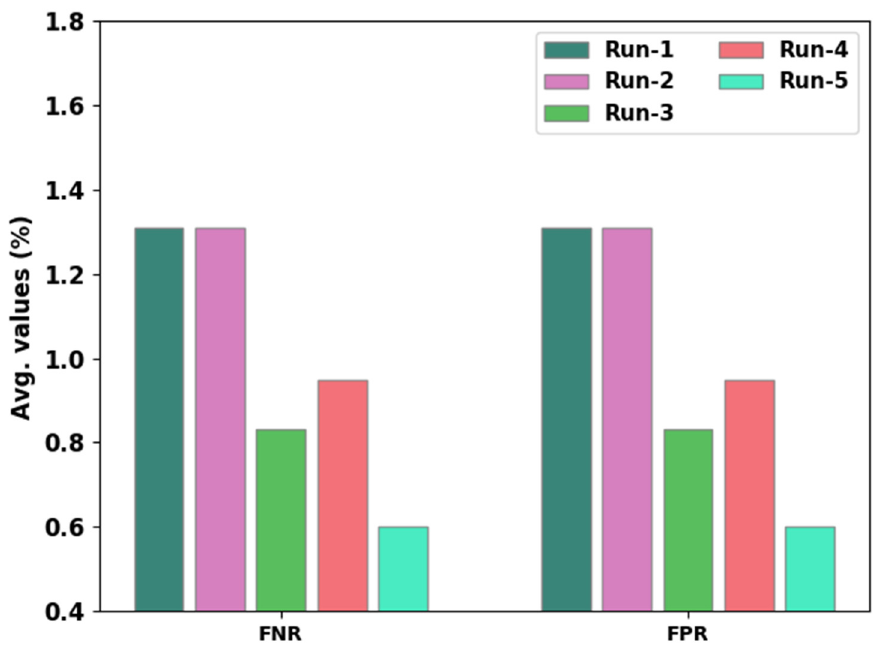
Figure 5. Average FNR and FPR analysis of DWOML-RWD approach with distinct runs.